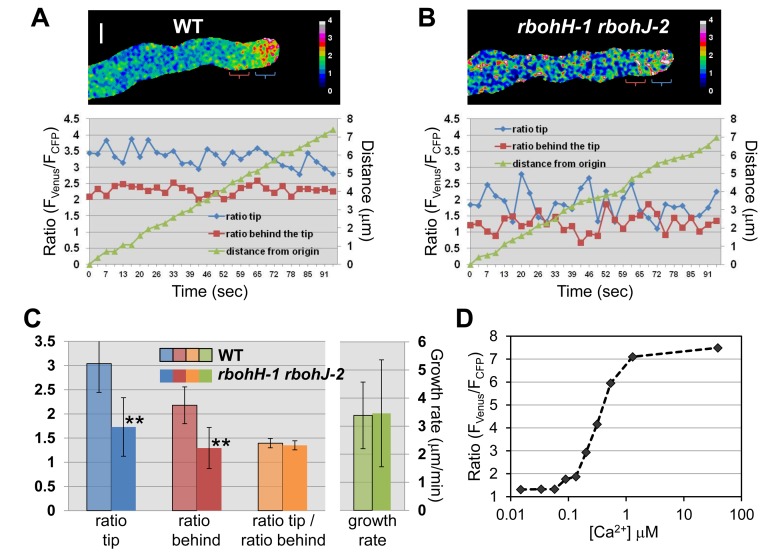
Ca2+-sensitive cameleon YC3.60 ratiometric imaging shows that [Ca2+]cyt levels are decreased and less steady in growing rbohH-1 rbohJ-2 pollen tubes.(A) Representative images of growing WT PTs expressing cytosolic YC3.60 and the corresponding histogram displaying the ratios (FCFP/FVenus) at the PT tip (blue line) and behind the tip (red line) over 90 seconds, as well as the travelled distance of the PT tip (green line). On the ratiometric image, the blue and red parentheses indicate where the circles of 4 µm diameter were positioned for measurements at the PT tip and behind the tip, respectively. See also corresponding Video S6. Scale bar = 5 µm. (B) Representative images of growing rbohH-1 rbohJ-2 PTs expressing cytosolic YC3.60. For details, see (A). (C) Quantification of YC3.60 ratio (FCFP/FVenus) at the PT tip (blue bars) and just behind the tip (red bars), as well as the tip-focused Ca2+gradient (ratio at the tip/ratio behind the tip; orange bars) and growth rates (green bars) of growing WT (n = 46) and rbohH-1 rbohJ-2 (n = 30) PTs. Data are shown as the mean of ratios or growth rates over 90 seconds ±standard deviation (SD). Double asterisks indicate significant differences from the WT according to a Student's t test with p<0.01. (D) Titration curve for YC3.60.